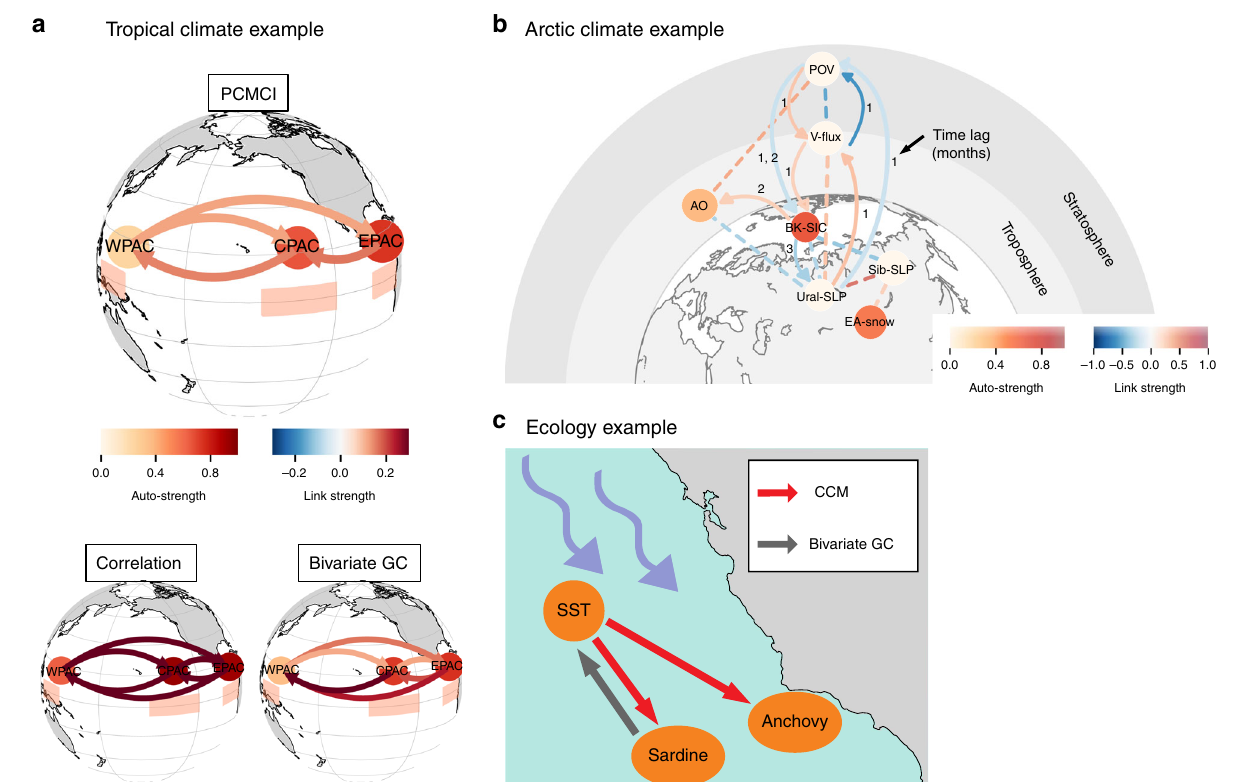
Fig. 1 Example applications of causal inference methods in Earth system sciences. a Tropical climate example of dependencies between monthly surface pressure anomalies in the West Paci fi c (WPAC, regions depicted as shaded boxes below nodes), as well as surface air temperature anomalies in the Central Paci fi c (CPAC) and East Paci fi c (EPAC). Correlation analysis and standard bivariate Granger causality (GC) result in a completely connected graph while a multivariate causal method (PCMCI) 23,24 better identi fi es the Walker circulation: Anomalous warm surface air in the East Paci fi c is carried westward by trade winds across the Central Paci fi c. Then the moist air rises towards the upper troposphere over the West Paci fi c and the circulation is closed by the cool and dry air sinking eastward across the entire tropical Paci fi c. PCMCI systematically identi fi es common drivers and indirect links among time-lagged variables, in this particular example based on partial correlation tests. Details on data in ref. 53 . b Application of a similar method to Arctic climate 25 : Barents and Kara sea ice concentrations (BK-SIC) are detected to be important drivers of mid-latitude circulation, in fl uencing winter Arctic Oscillation (AO) via tropospheric mechanisms and through processes involving vertical wave activity fl uxes (v- fl ux) and the stratospheric Polar vortex (PoV). Details on methodology and data in ref. 25 . © American Meteorological Society. Used with permission. c Application from ecology (details in ref. 11